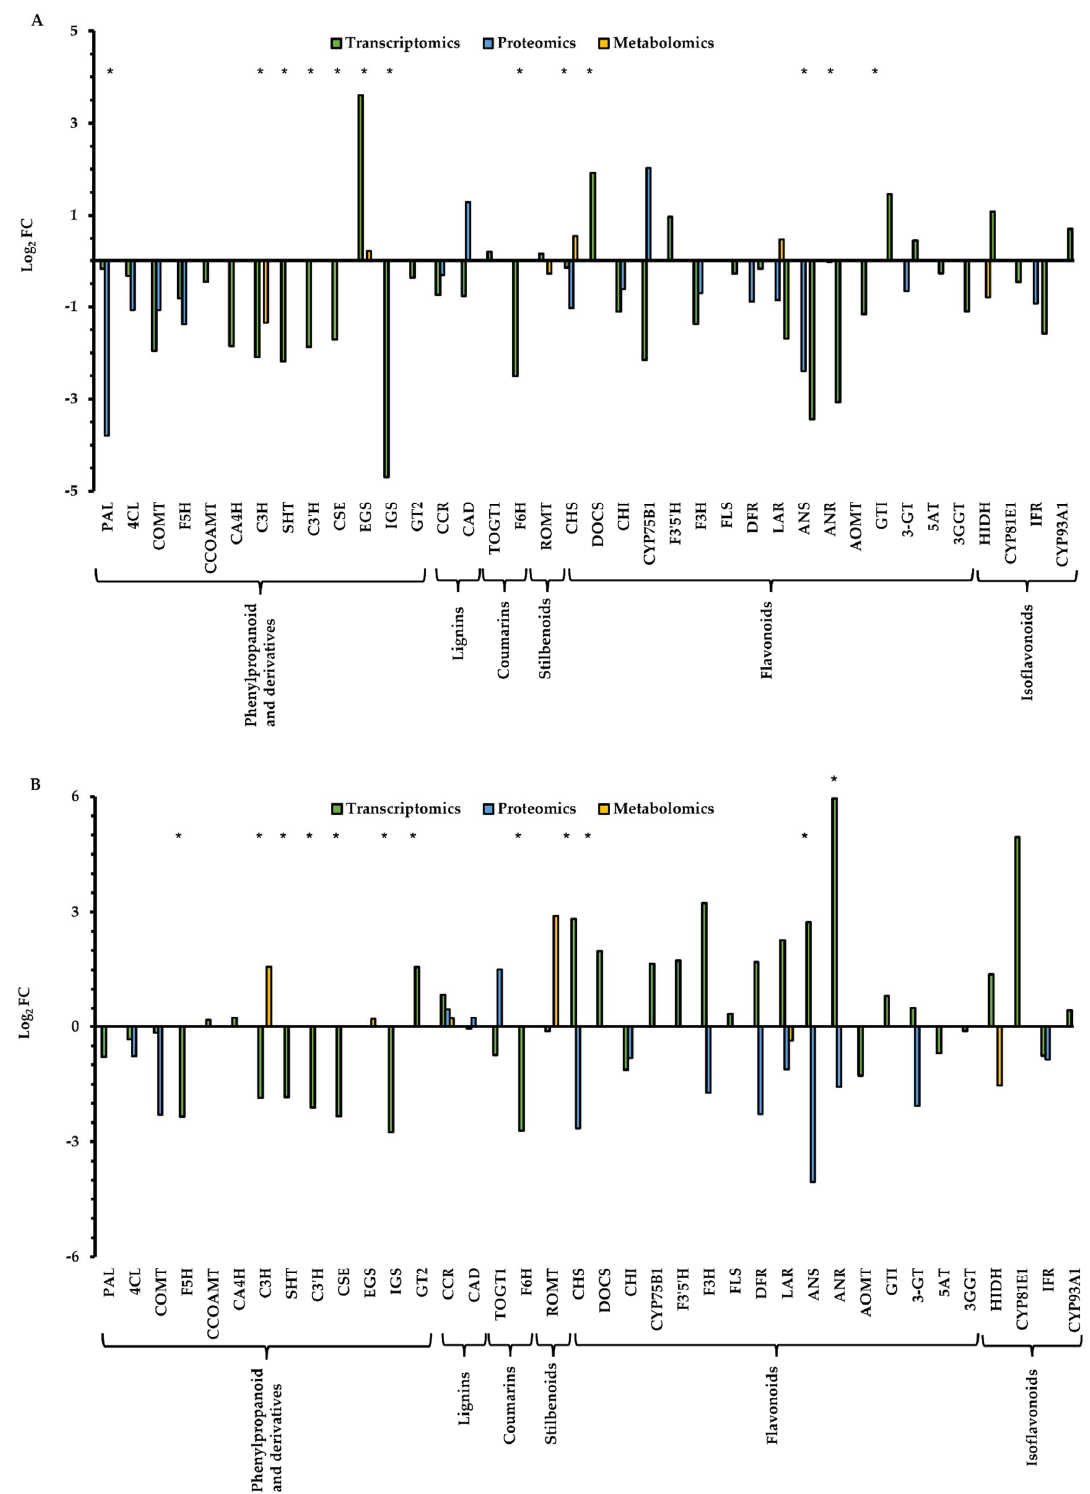
Figure 2. Integrated multi-omics analysis of phenolic compound-related enzymes in Q. ilex .